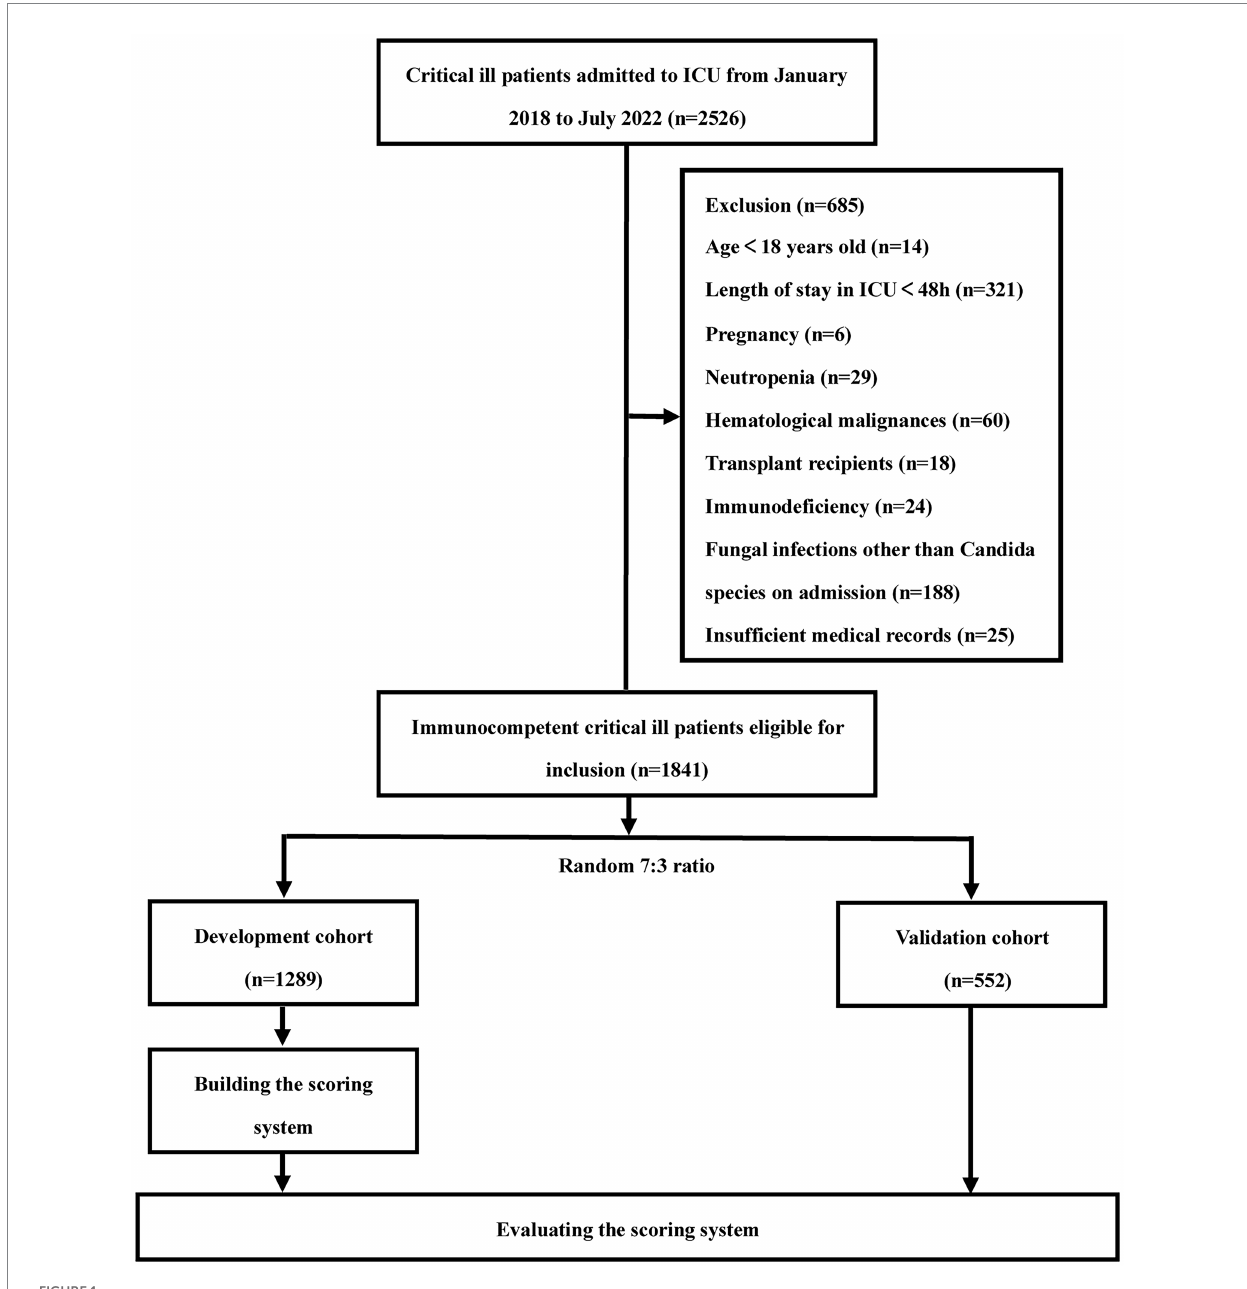
FIGURE 1 Flow diagram of the study